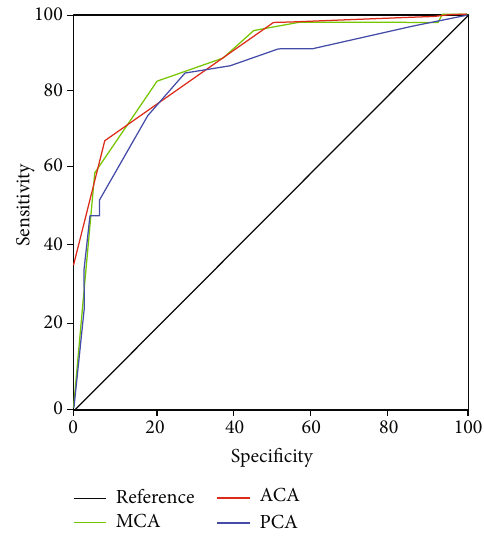
Figure 5: MFV cut-o ff values detected by the ROC